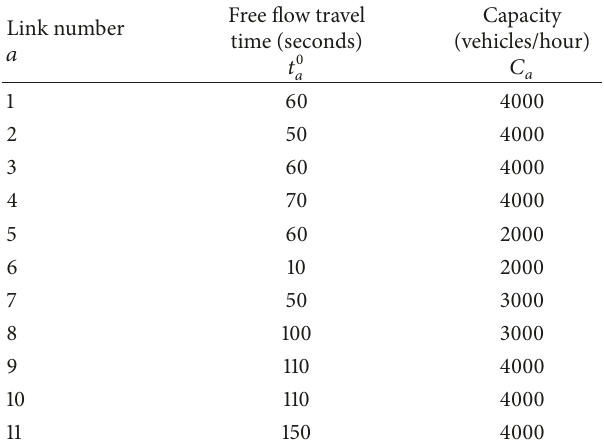
Table 2: Parameters in link travel time